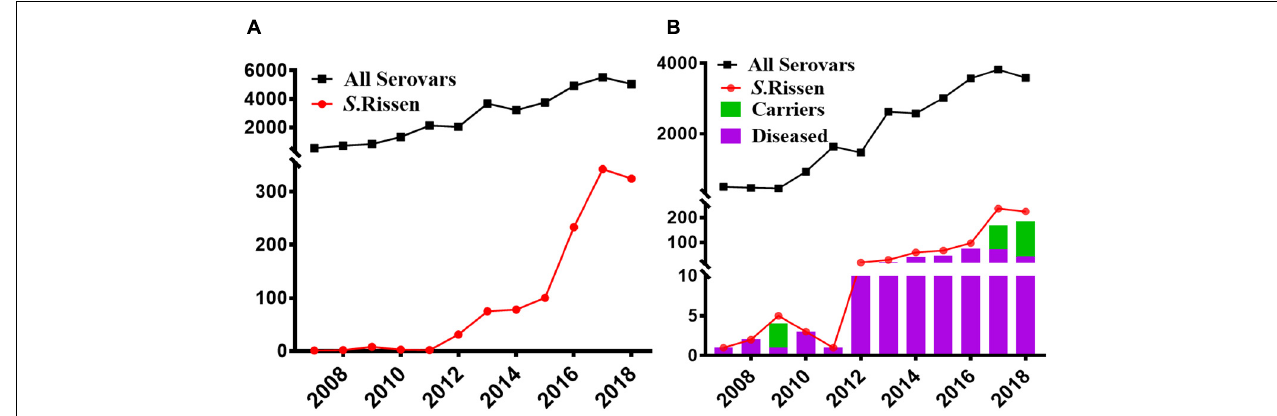
FIGURE 1 | Increasing trend of the Salmonella serovar Rissen in China between 1995 and June 2019. (A) An emerging trend of S . Rissen in China as compared to other Salmonella serovars. (B) An emerging trend of S . Rissen serovar in humans in addition to the prevalence of clinical patients and asyndromatic carriers in China as compared to other Salmonella